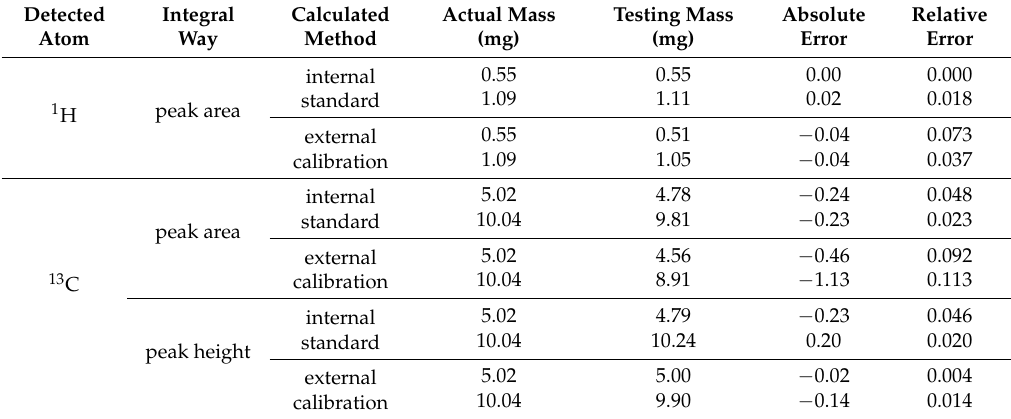
Table 3. Relative errors of glycerol amounts predicted by 1 H and 13 C NMR methods